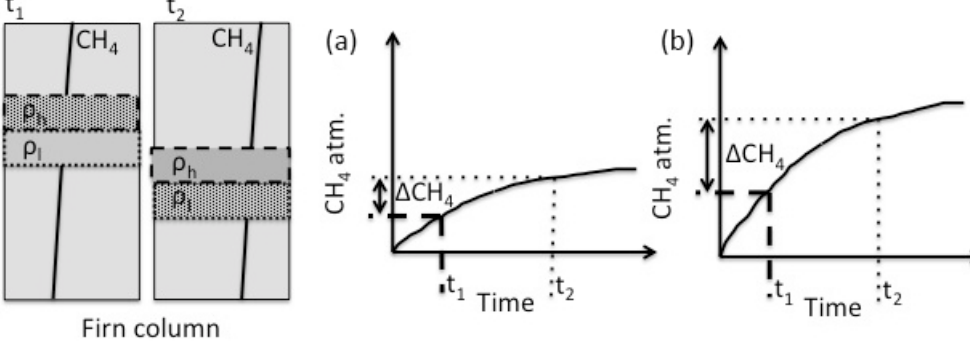
Figure 1. Schematic to illustrate how the layered bubble trapping mechanism can generate high-frequency CH 4 artifacts in ice cores. At time t 1 , air bubbles within the relatively high-density ( p h ) layer are closed off at a relatively shallow depth in the firn column. At time t 2 , air bubbles with the relatively low-density ( p l ) layer are closed off deeper in the firn column. Between t 1 and t 2 the atmospheric concentration of CH 4 is increasing and so the CH 4 concentration in the diffusive column also increases, generating a CH 4 concentration difference (cid:49) CH 4 between the bubbles in depth-adjacent layers trapped at t 1 and t 2 . Increasing the atmospheric CH 4 growth rate ( b compared to a ) results in a larger (cid:49) CH 4 . A negative atmospheric growth rate would cause a change in the sign of (cid:49) CH 4